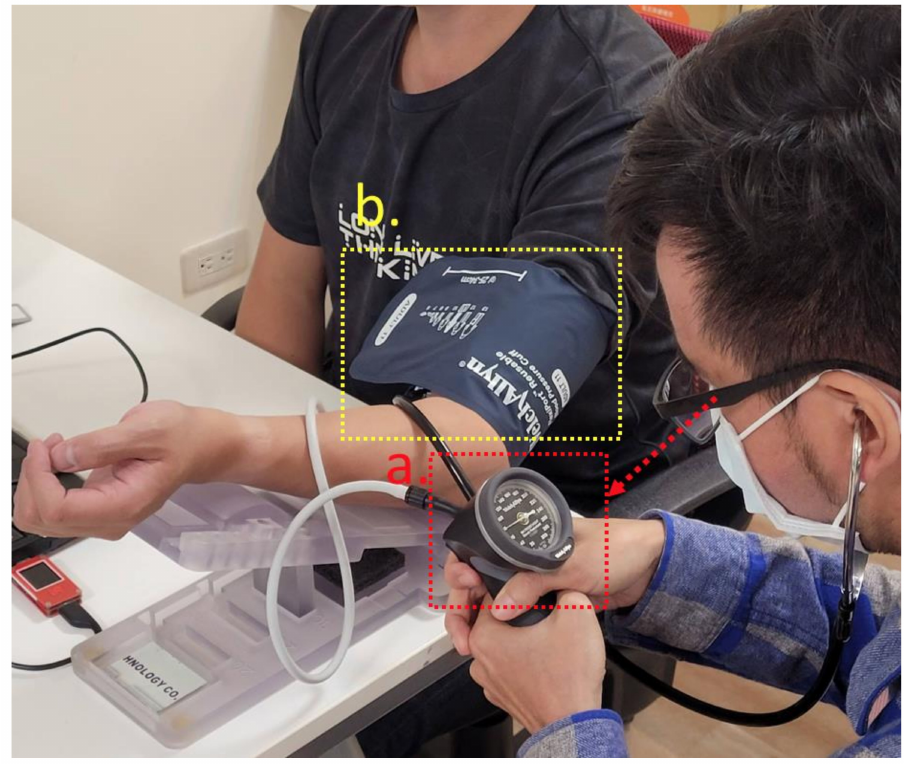
Figure 12. ( a ) Welch Allyn 5098-27 DS66 aneroid sphygmomanometer; ( b ) subject wearing the cuff with a stethoscope between the cuff and the arm, and the researcher pressurizing the